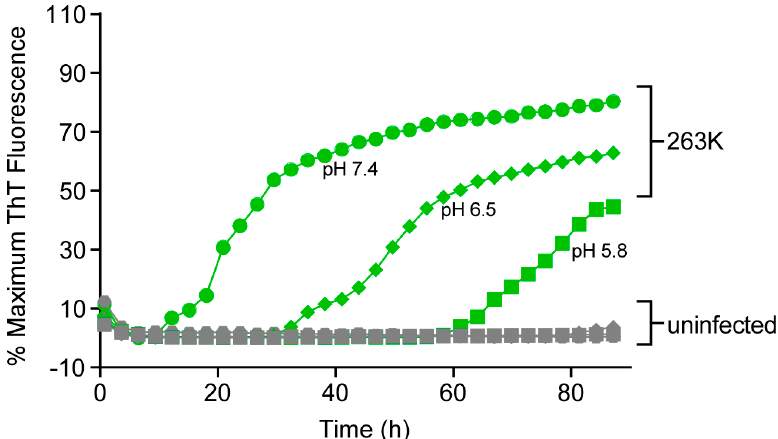
Figure 7. Influence of pH on RT-QuIC amplification kinetics. Quadruplicate RT-QuIC reactions were seeded with 2 μ L of 5 × 10 − 8 scrapie positive (263K, green) or uninfected (gray) hamster brain tissue dilutions. The reaction mix was prepared as indicate in Materials and Methods with adjustments of